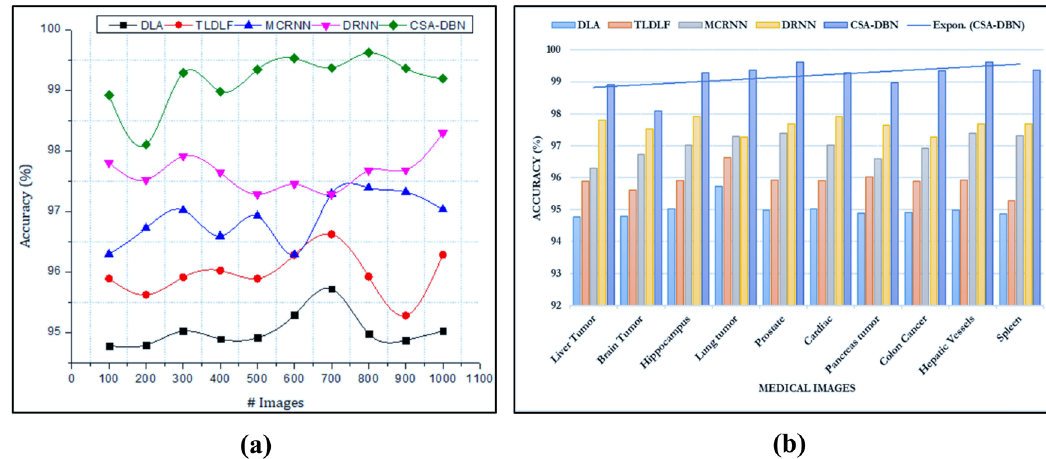
Figure 5: Accuracy analysis: ( a ) # images and ( b ) di ff erent